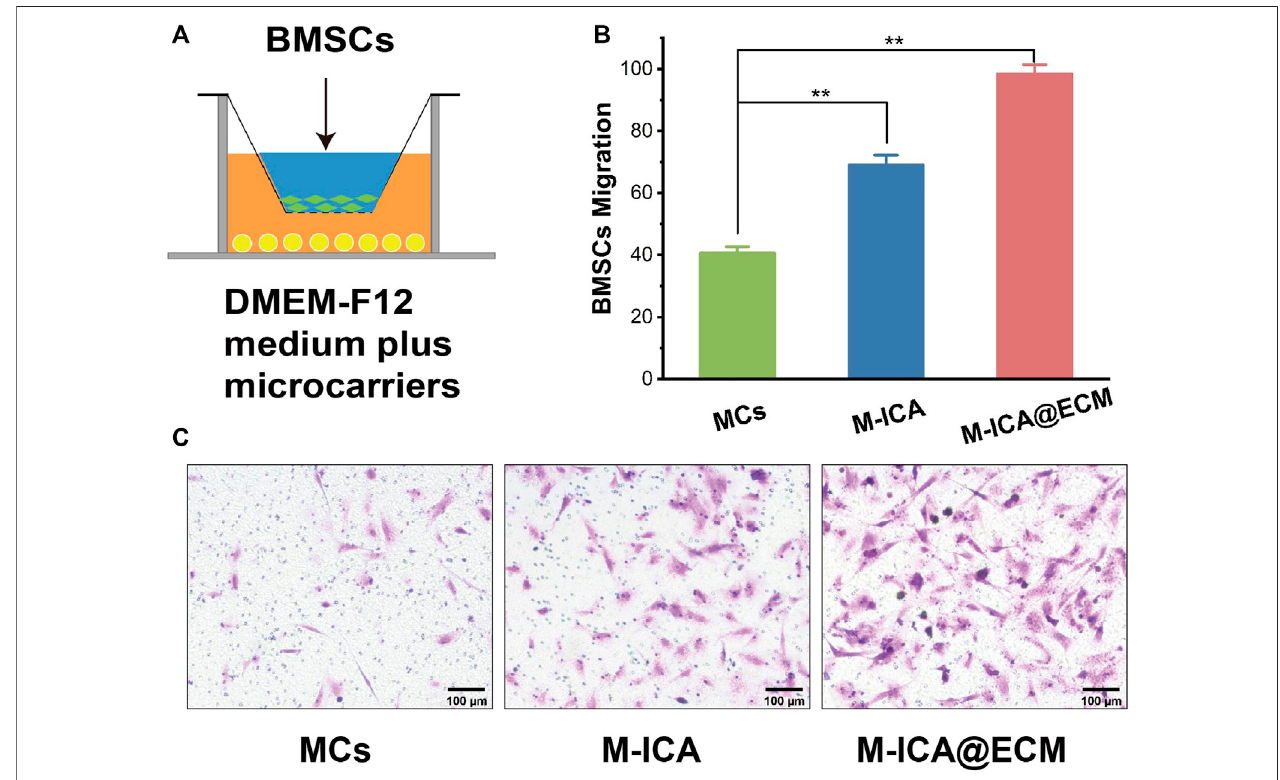
FIGURE6| Transwellmigrationassay: (A) Schematicdiagramofthetranswellsystem; (B) MigratedBMSCscountedindifferentgroups; (C) Microscopeimagesof migrated BMSCs induced by MCs, M-ICA and M-ICA@ECM (Scale bar = 100 μ m) (* p < 0.05, ** p < 0.01, n = 5).